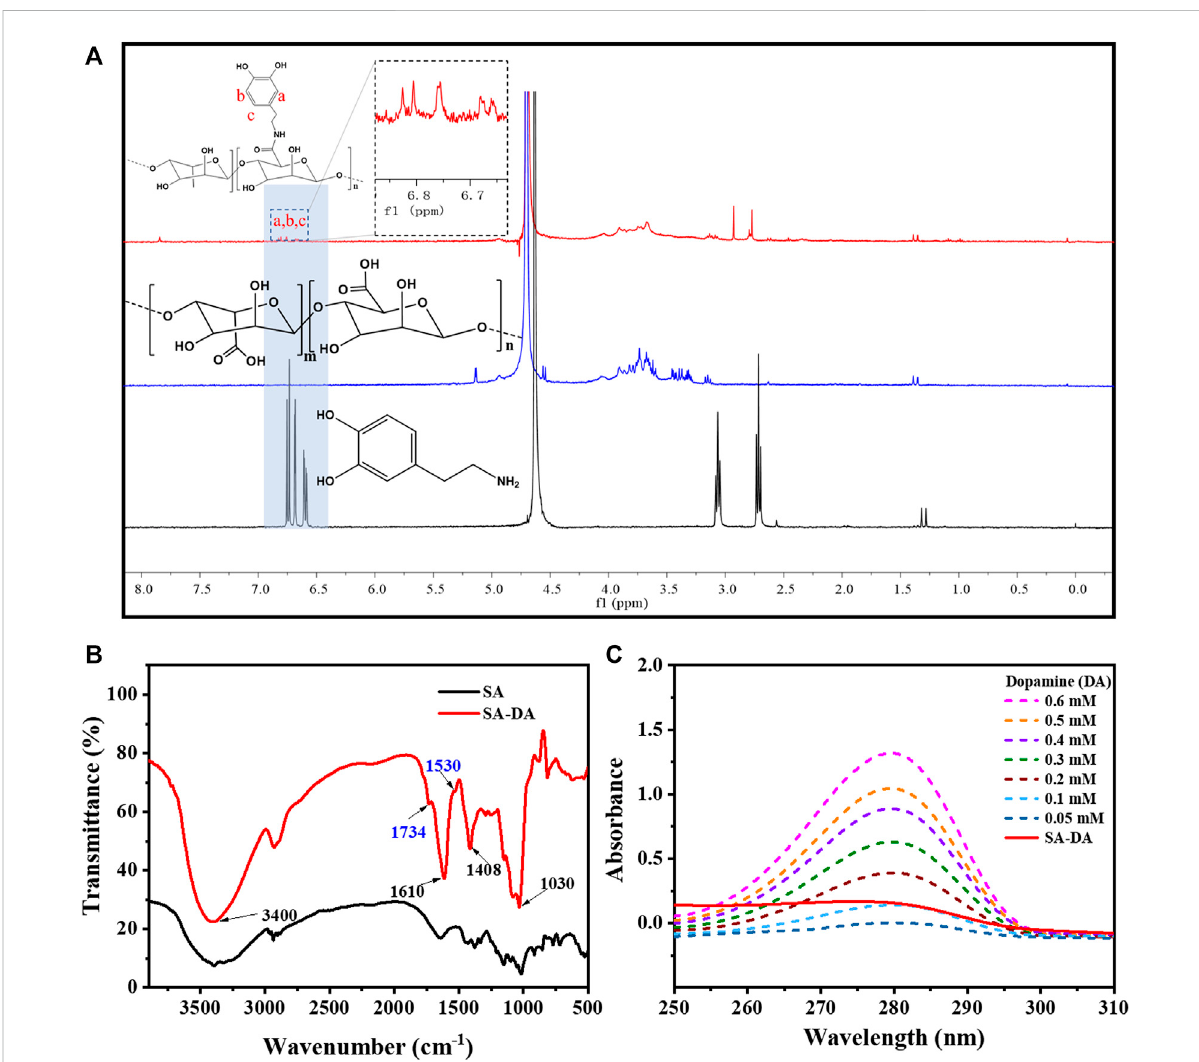
FIGURE 1 Characterization of SA-DA: (A) 1 H NMR spectra of SA, DA, and SA-DA; (B) FT-IR spectra of SA and SA-DA; and (C) UV spectra of the dopamine and SA-DA solutions with different concentrations.